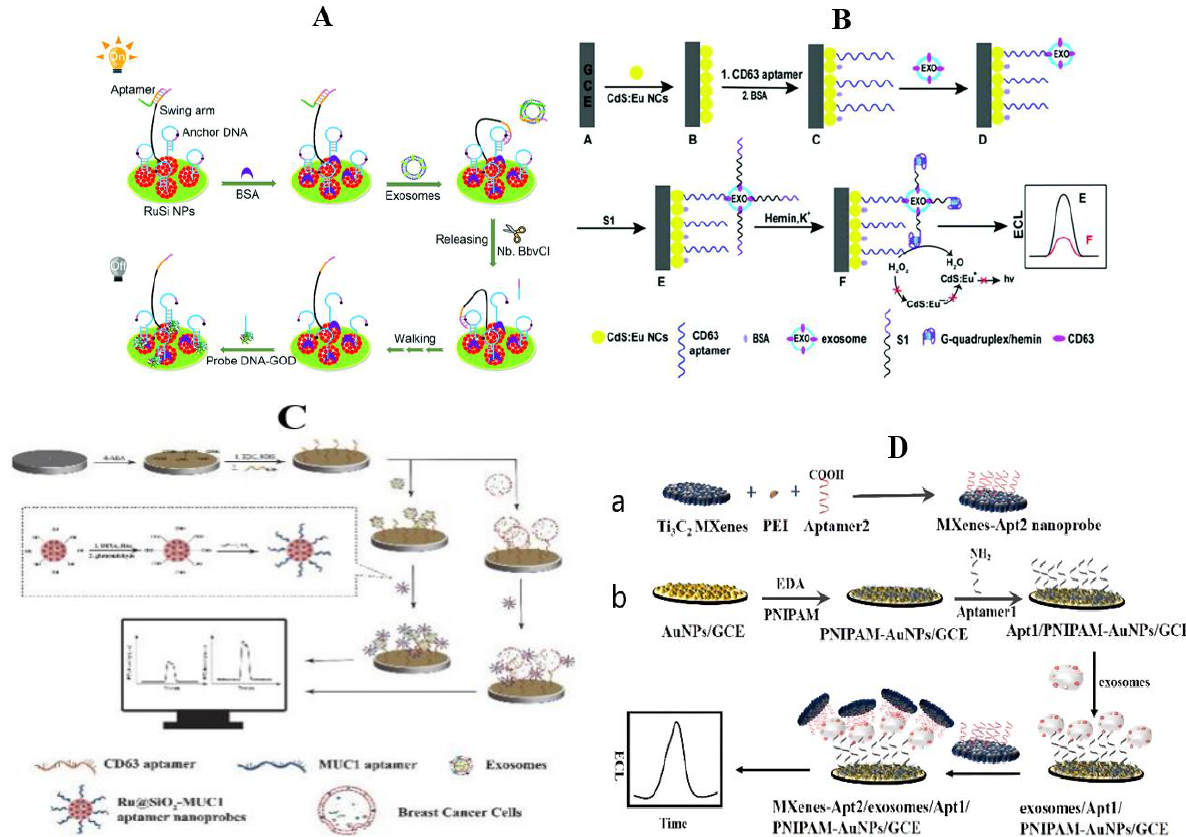
Figure 10. Detection of exosomes in breast cancer by electrochemiluminescence. (A) Schematic representation of an aptamer-binding DNA walking machine for ECL detection of tumor exosomes [164]; (B) schematic illustration of the ECL aptasensor for exosome detection based on the G-quadruplex/hemin DNAzyme [165]; (C) schematic illustration of an ECL aptasensor for the detection of MUC1 protein on breast cancer cells and their derived exosomes [166]; (D) the principle of the ECL biosensor for an exosome activity detection signal-amplification strategy [167].